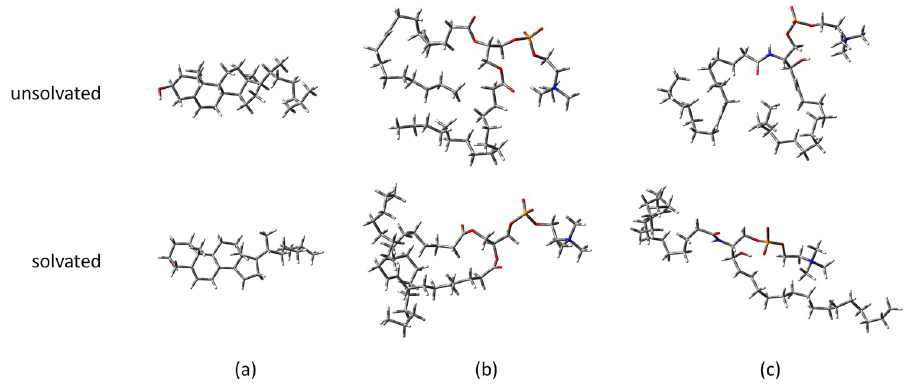
Fig 14. The docked structures of lipids with RMSD = 0 in solvated and unsolvated PHF-Tau. (a) cholesterol; (b) 1-palmitoyl-2-oleoyl-sn-glycero-3-phosphocholine; and (c) C18:1 sphingomyelin.